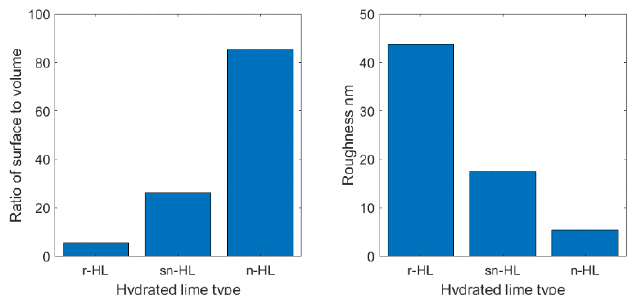
Figure 18. The physical properties of HL particles.